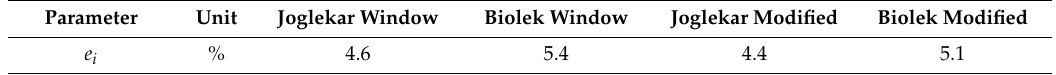
Table 3. Parameters for comparison the applied memristor